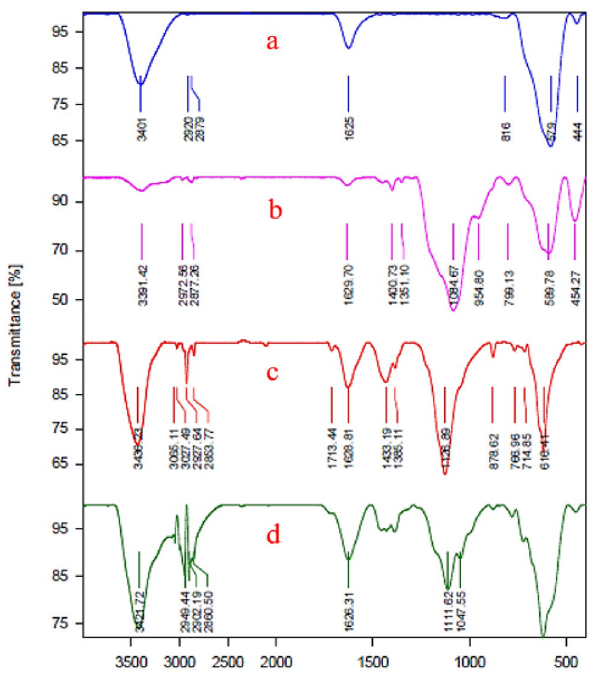
Figure 1. FT-IR spectra of Fe 3 O 4 ( a ), Fe 3 O 4 -CPTMS ( b ), Fe 3 O 4 -PTMS-NAS ( c ) and Fe 3 O 4 -PTMS-NAS@Cu MNPs ( d ).